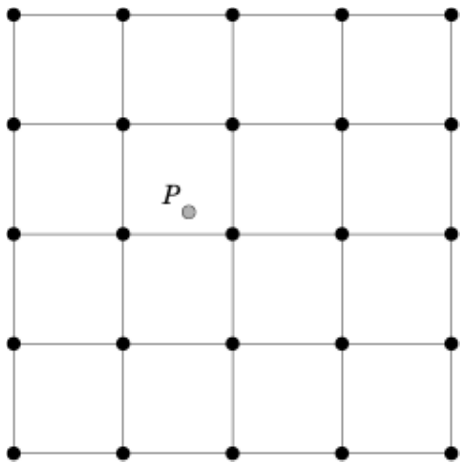
Figure 5 . Illustration of the nearest neighbor interpolation method used for the calculation of the skill scores [36].